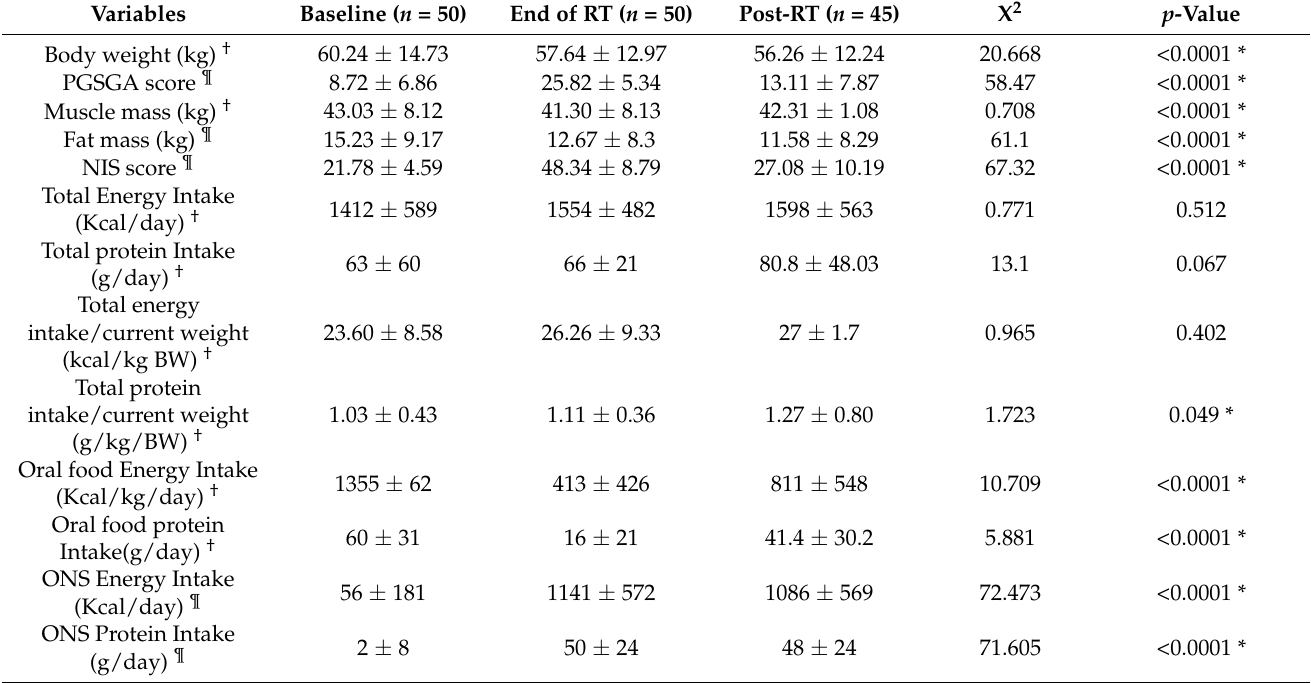
Table 2. Changes in nutritional status and NIS at baseline, end and post-treatment.